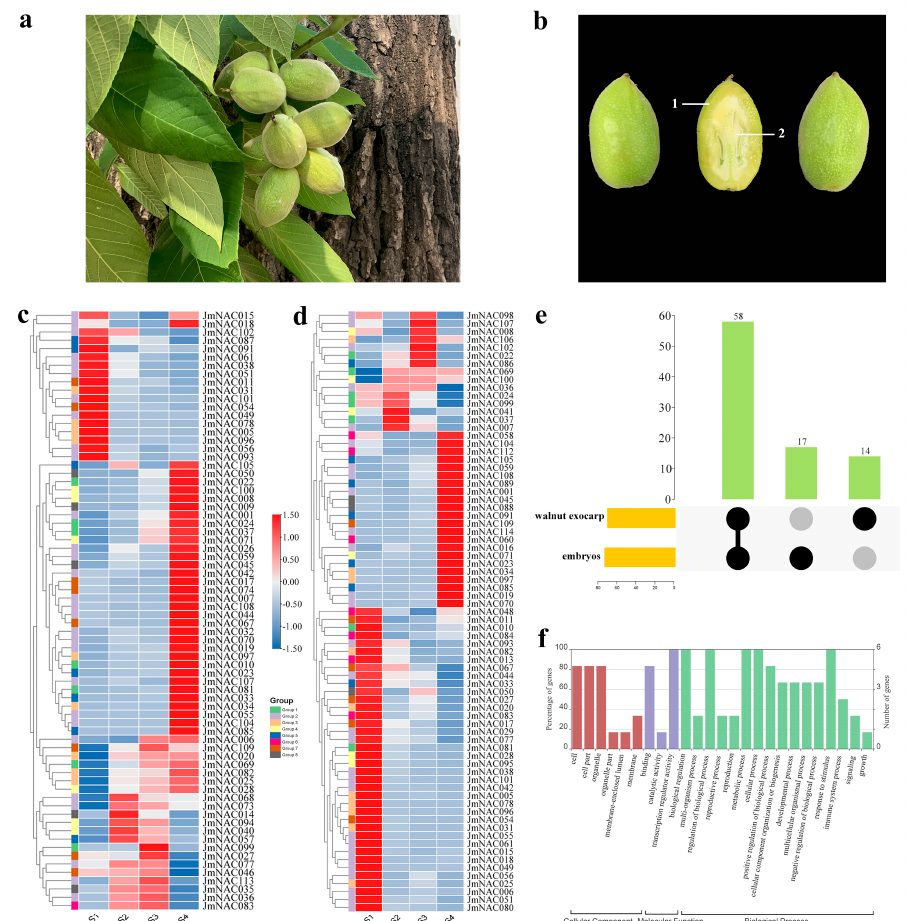
Figure 6. Expression profiles and functional analysis of JmNAC genes in different stages of fruit development and ripening. ( a ) Photographs of J. mandshurica fruits. ( b ) The tissue structure of J. mandshurica fruit. “1” indicates the walnut exocarp. “2” indicates the walnut embryos. ( c ) Heatmap representing 75 JmNAC gens in walnut exocarp at 30 days (S1), 50 days (S2), 70 days (S3) and 90 days (S4) after natural pollination. ( d ) Heatmap representing 75 JmNAC gens in walnut embryos at 30 days (S1), 50 days (S2), 70 days (S3) and 90 days (S4) after natural pollination. Group I–VIII correspond to the subgroups in the phylogenetic tree in Figure 2. ( e ) Upset plot of JmNAC genes expressed in walnut exocarp and embryos. ( f ) GO annotation analyses of the common JmNAC genes expressed in walnut exocarp and embryos.